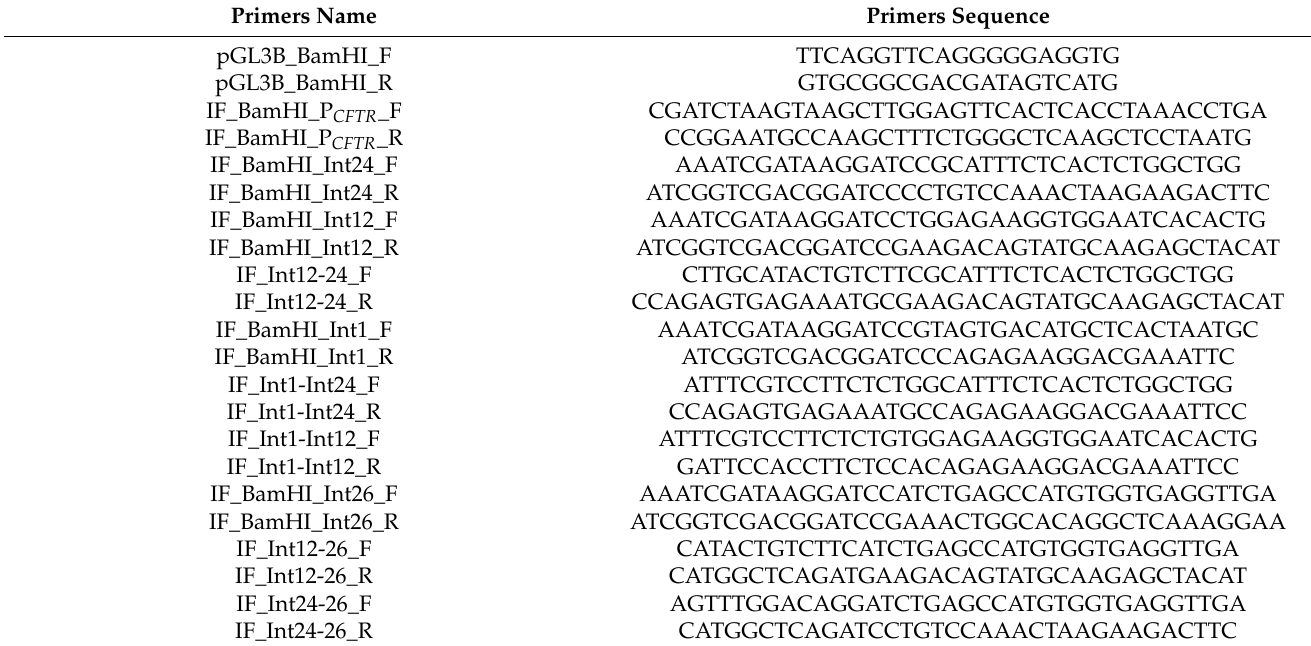
Table A2. Primers used for luciferase reporter constructions.